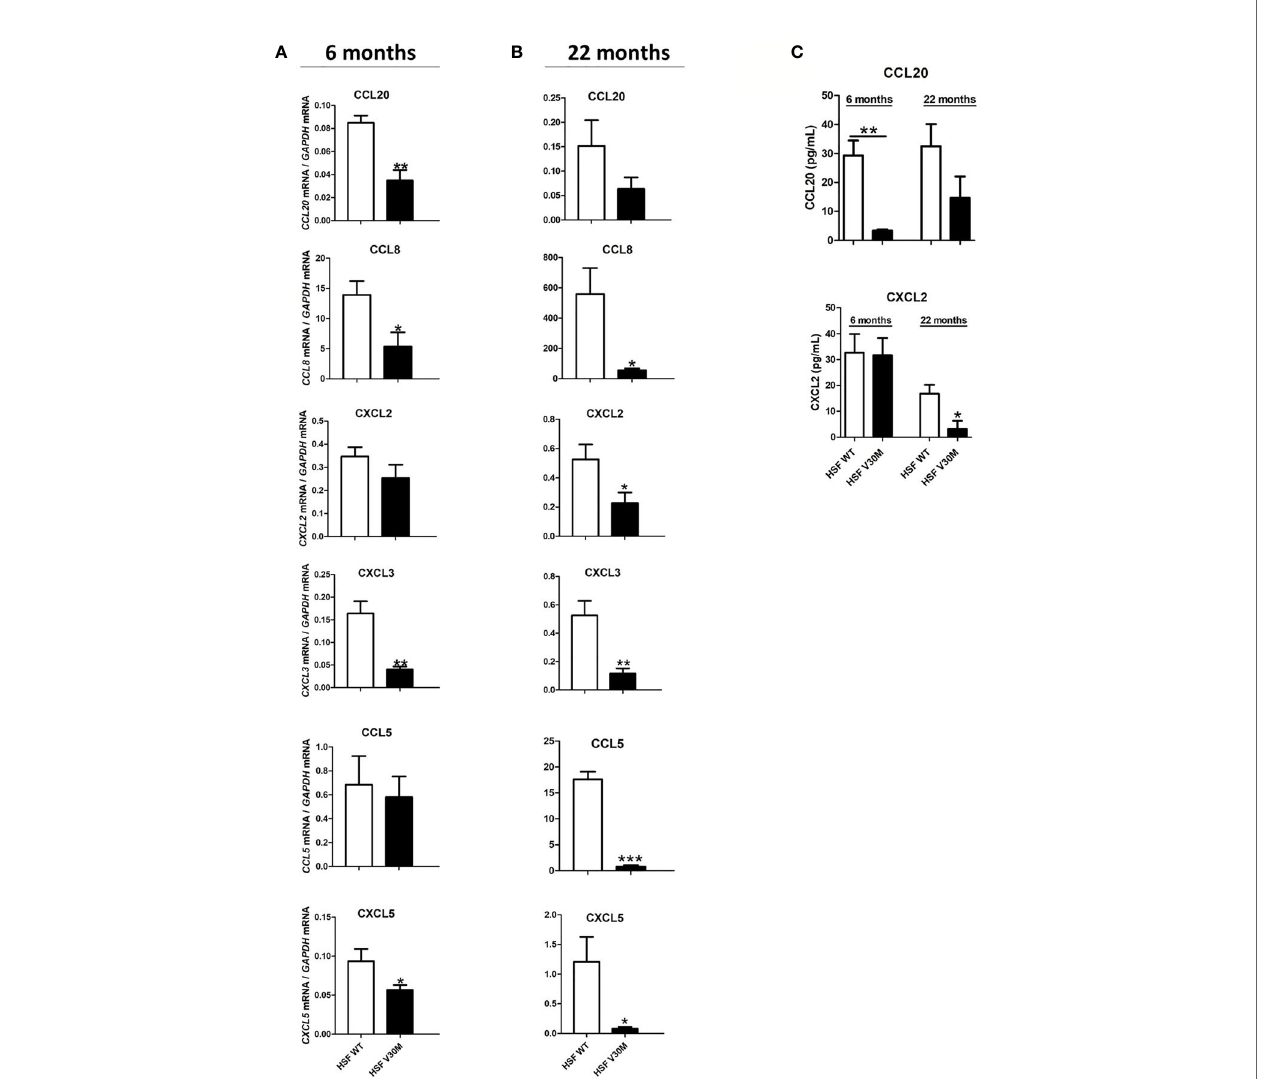
FIGURE 1 | The levels of several chemokines were downregulated in an ATTRv mouse model of the disease. RNA was extracted from sciatic nerve of HSF WT and HSF V30M mice with 6 (A) and 20 (B) months of age and the levels of several chemokines were found highly downregulated in the sciatic nerve of HSF V30M mice at both ages. (C) Decreased plasma levels of CCL20 and CXCL2 were measured by ELISA in the serum of HSF V30M mice with 6 and 20 months of age. Data were analyzed using one-way ANOVA followed by Bonferroni post-test and represented as mean ± s.e.m (*P < 0.05; **P < 0.01; ***P <